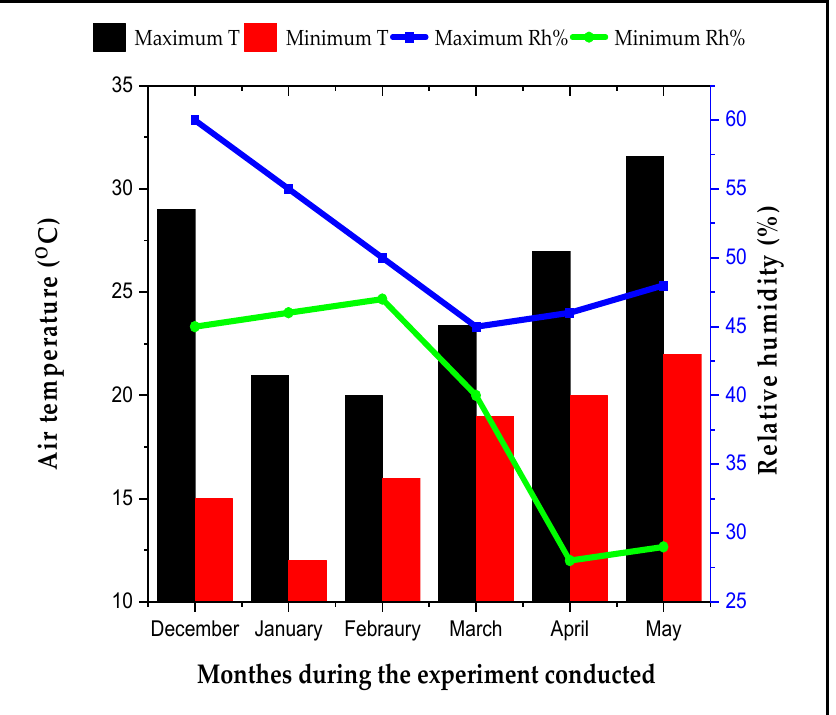
Figure 10. Monthly weather data of The Experimental Farm, Faculty of Agriculture, Cairo University, Giza, Egypt. Minimum air temperature (minimum T ( ◦ C)), maximum air temperature